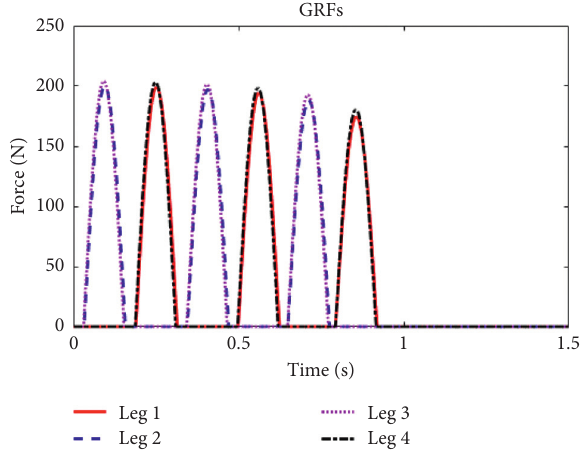
Figure 9: GRFs of the passive model at 1.84m/s.